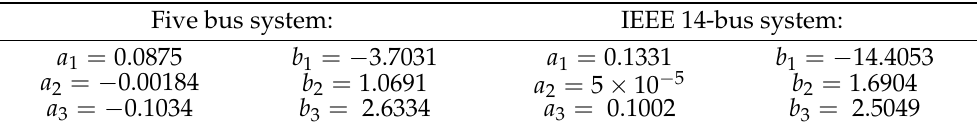
Table 1. Load flow solutions for the five-bus system under normal operating conditions.